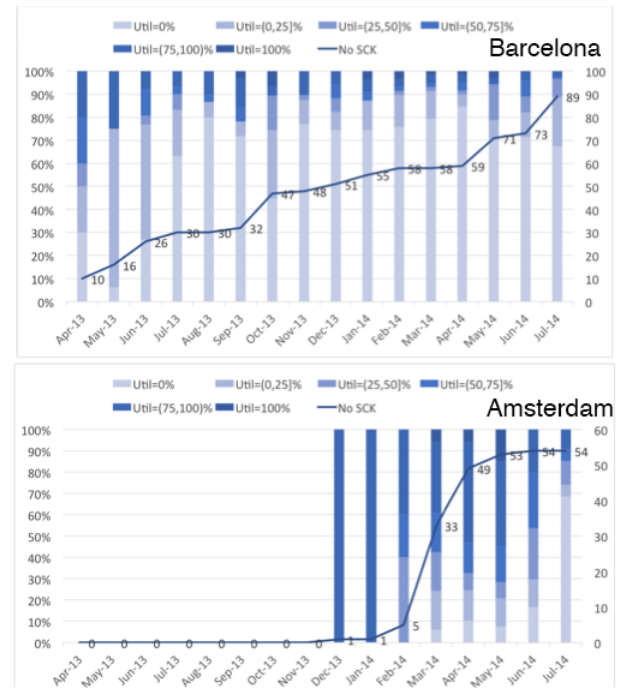
Figure 2: Breakdown of SCK population (in number of connected sensors) and level of utilisation (in percentages) across Barcelona and